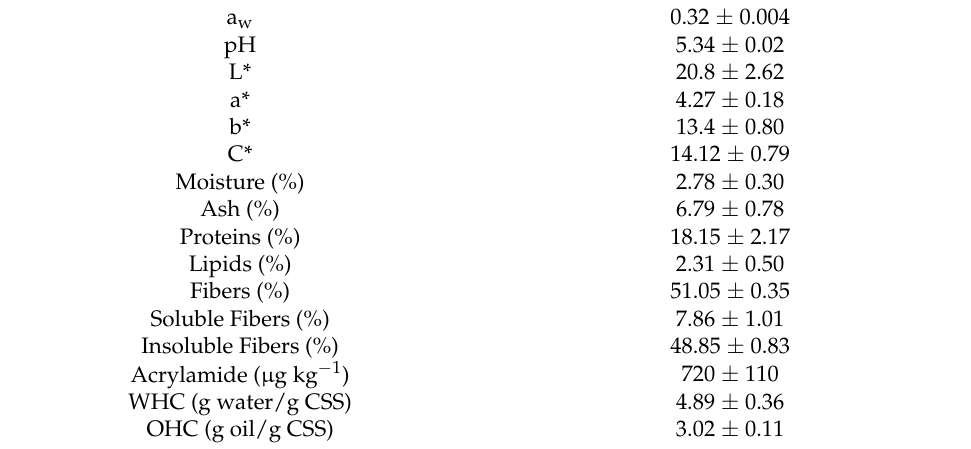
Table 2. Physico-chemical, color, and chemical characterization of